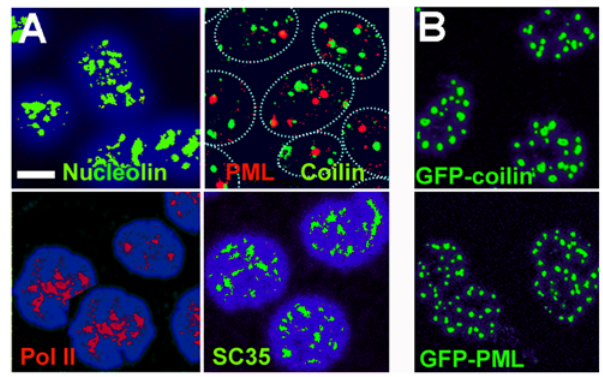
Figure 3. Internal compartments in nuclei isolated in 50% Ficoll, 100 m M K-Hepes. (A) distribution of nucleolin (nucleoli), PML (PML bodies), coilin (Cajal bodies), RNA polymerase II (pol II) (transcription factories) and SC35 (speckles). Nuclei of K562 cells were isolated in polymer solution, deposited on slides, and fixed as described in Figure 1. In the upper right panel, approximate nuclear outlines were traced from an overexposed image. (B) distribution of GFP-coilin or GFP-PML isoform IV fusion proteins in nuclei of HeLa or U2OS cells, respectively. Cells were washed with polymer solution and permeabi- lised and extracted in situ. Images are maximum intensity projections from deconvoluted confocal series. Bar 5 m m.